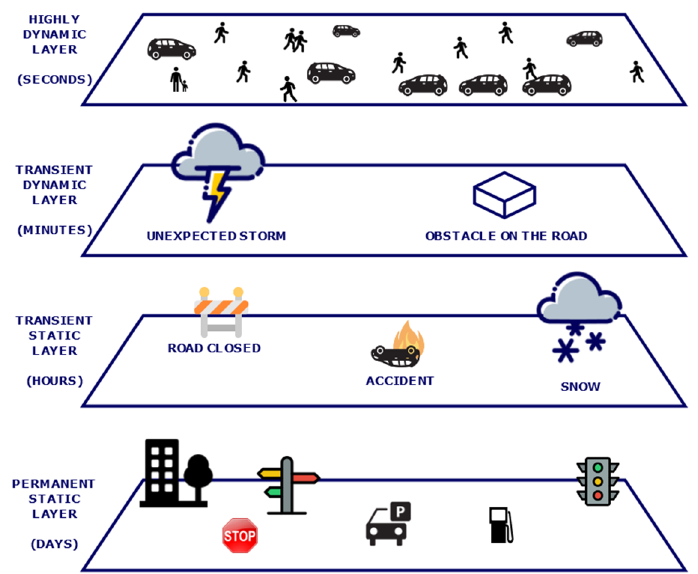
Figure 7. HD maps layers based on [28].